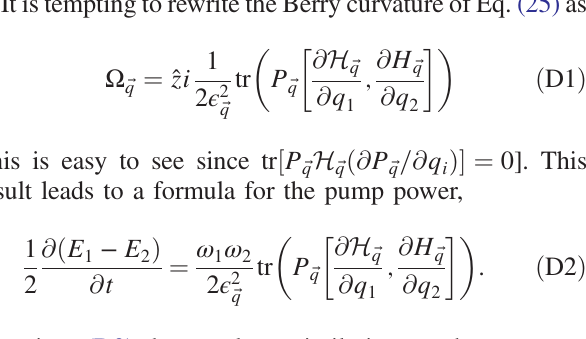
and Ψ 3363 = 2378 ≈ ð − 0 . 230 − 0 . 446 i; 0 . 865 Þ † ]. Both show